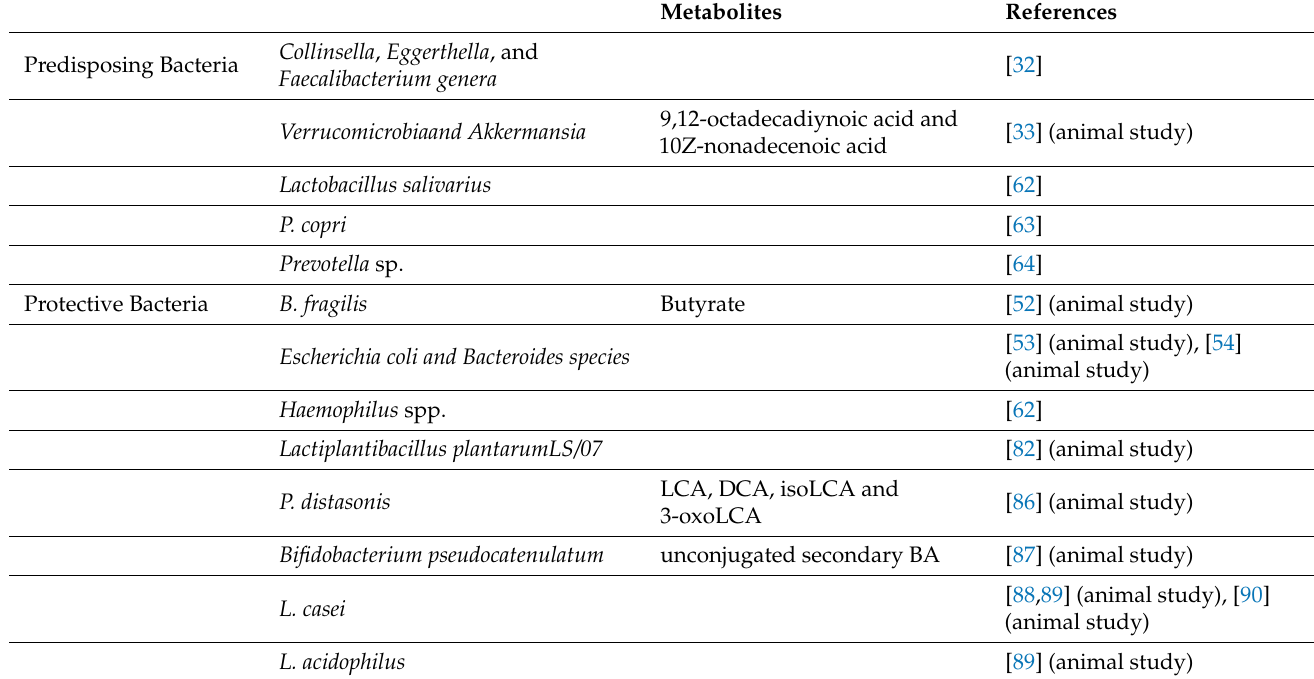
Table 1. The table reports the main studies on predisposing/protective gut bacteria involved in rheumatoid